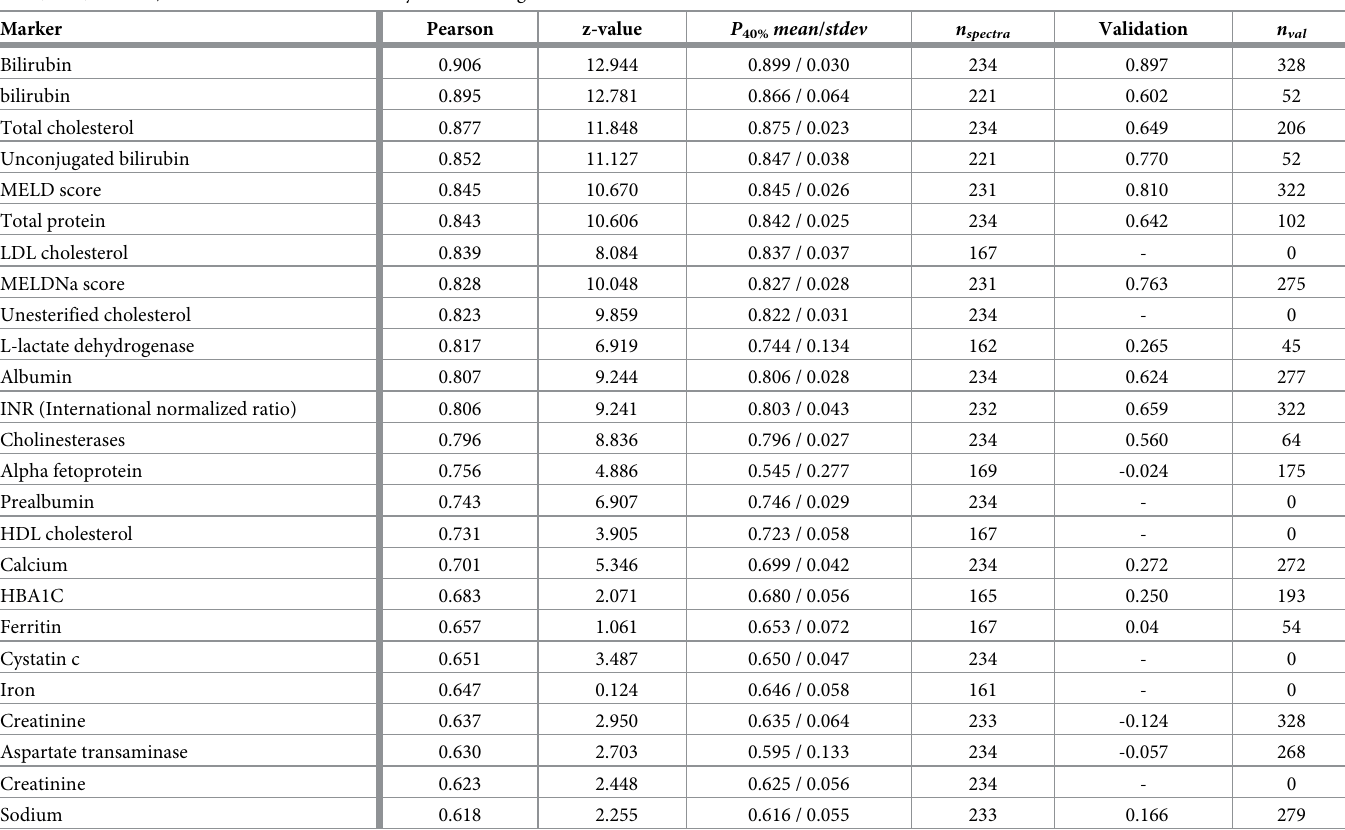
Table 2. Performance analysis for the highly correlating markers. With a minimum weight of 0.2 and 9 spectral vectors. This is background filtered data, with a mini- mum correlation of 0.6. The significance of the correlation is reported as z-value. The consistency is estimated by the mean value and the standard deviation of the Pearson score for an ensemble of random subsets of 40% size. For each marker, the number of available spectra is reported. Next, the correlation of the values predicted from 238 spectra from an independent cohort with laboratory data is listed, followed by the number of spectra in the validation set. Some of these markers (MELD score, MELDNa score, INR, HBA1C) cannot be detected in serum by standard